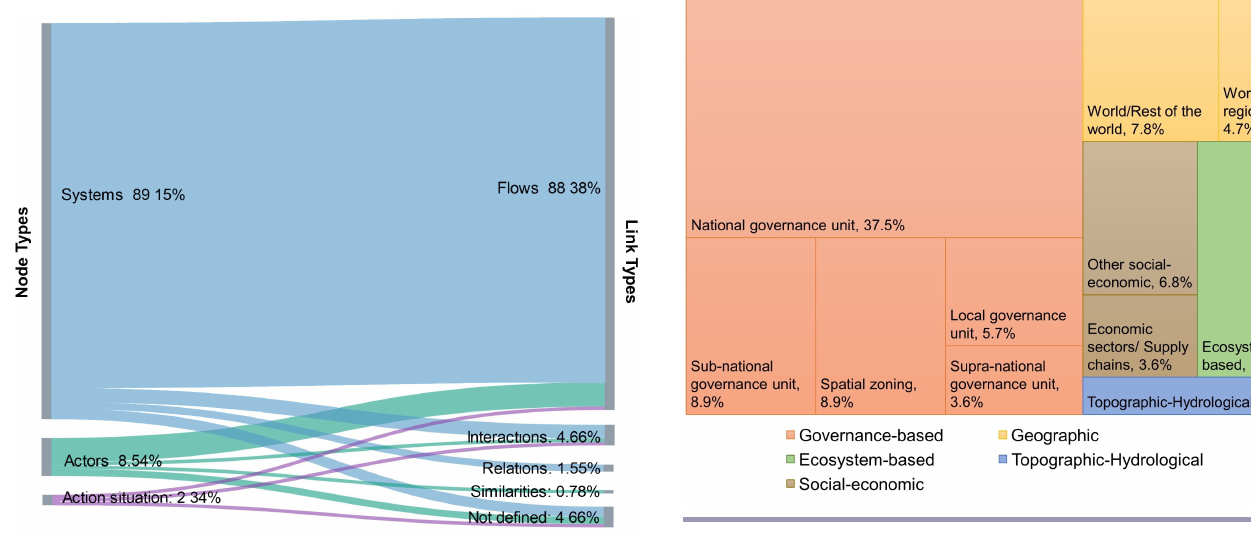
Fig. 5 . Node and link types represented in telecoupling visualizations and the combination thereof. Link types are based on Borgatti et al. (2009).